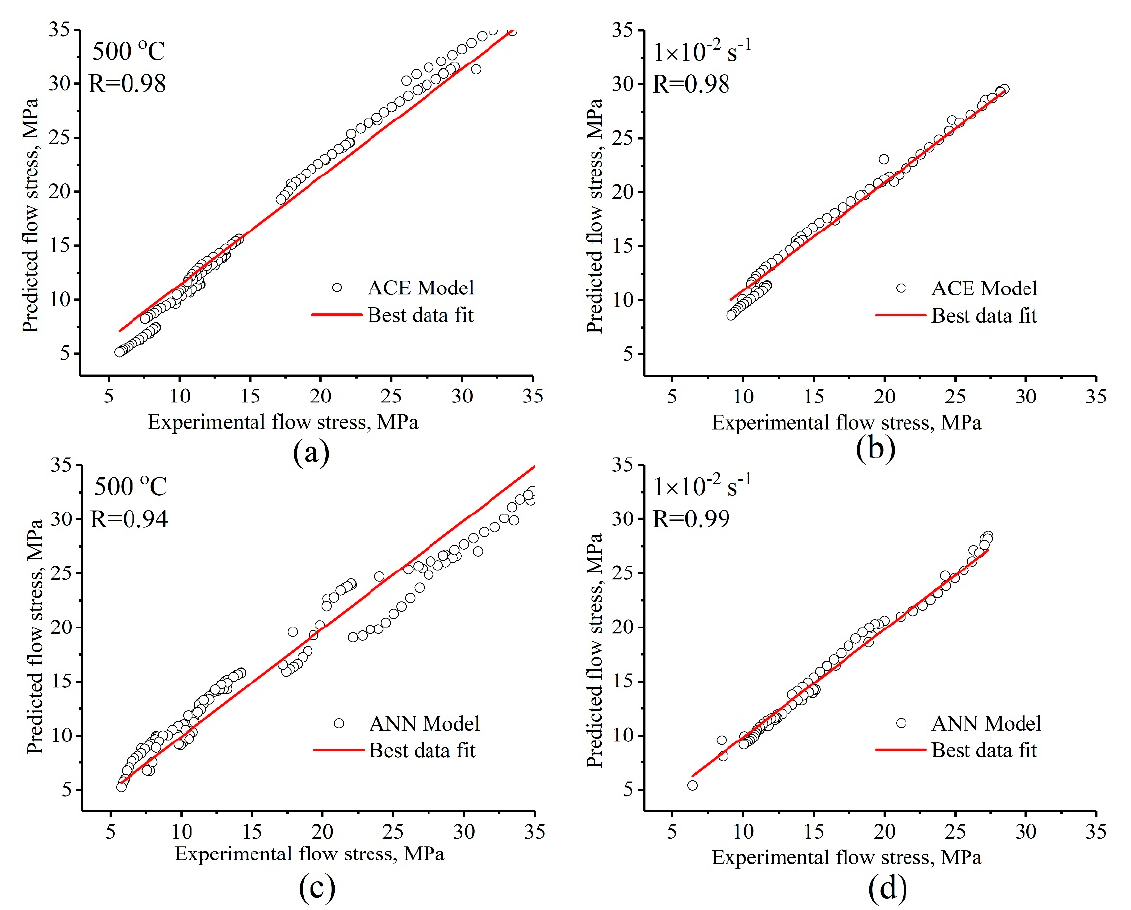
Figure 13. Correlation between the experimental and predicted flow stress obtained by ( a , b ) ACE and ( c , d ) ANN models.